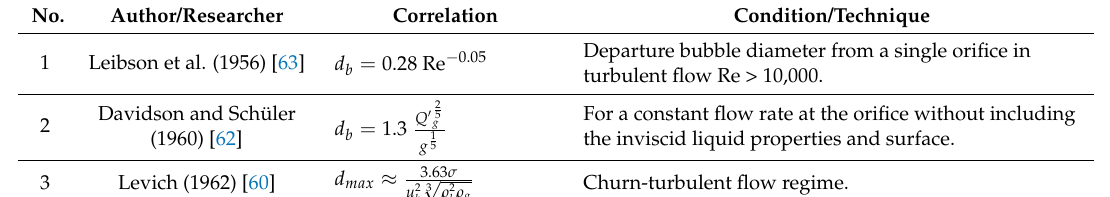
Table 1. Bubble size